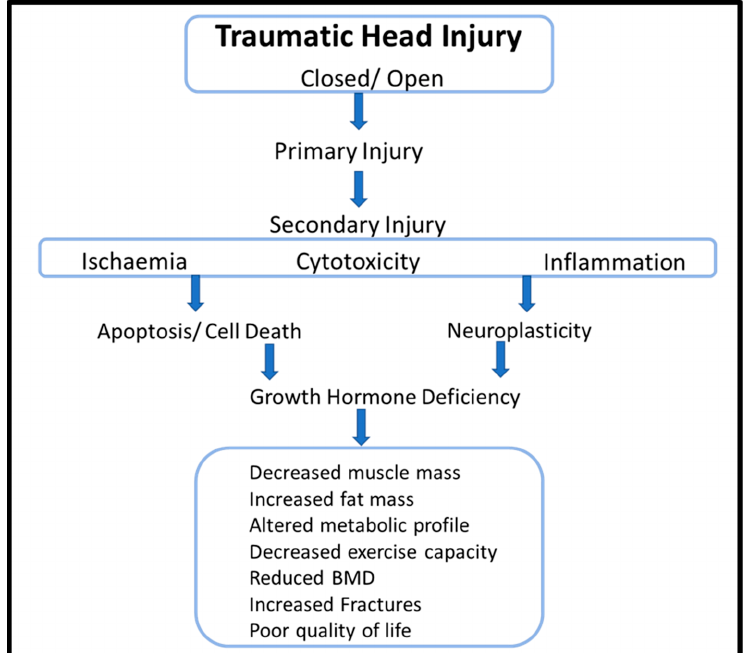
Figure 1. Pathophysiology and clinical features of growth hormone deficiency following traumatic brain injury.